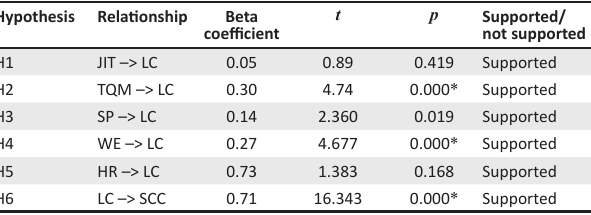
TABLE 7: Hypotheses decisions. Hypothesis Relationship